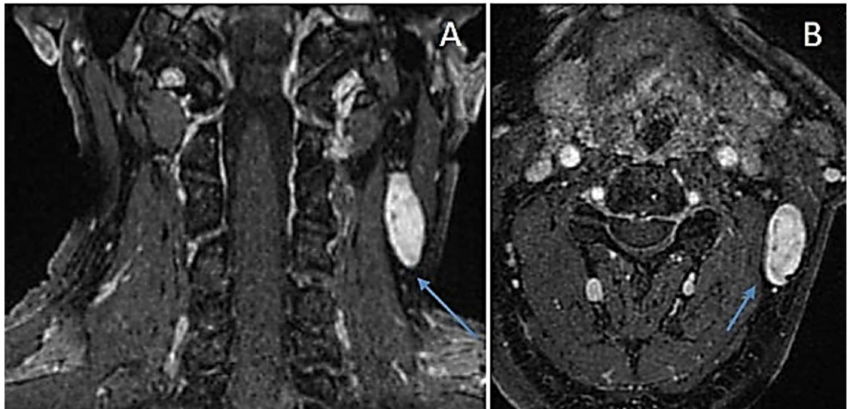
Figure 11. Solitary schwannoma of accessory spinal nerve. LAVA post-enhanced MRI: coronal view ( A ) and axial view ( B ) showing a non-homogenous well-defined mass (arrows) strongly enhancing along the tract of the accessory spinal